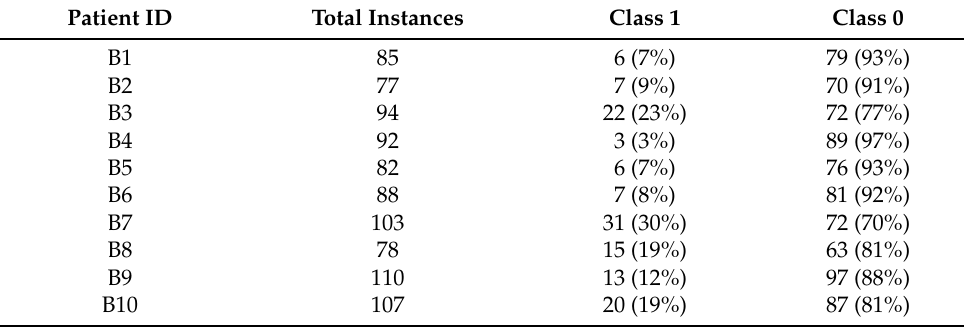
Figure 3. Graphical representation of the nocturnal hypoglycemia classifier. Table 1. Total number of instances for the ten patients of the Barcelona data set. Class 0 is defined as a sleep period without hypoglycemia and Class 1 is defined as a sleep period with